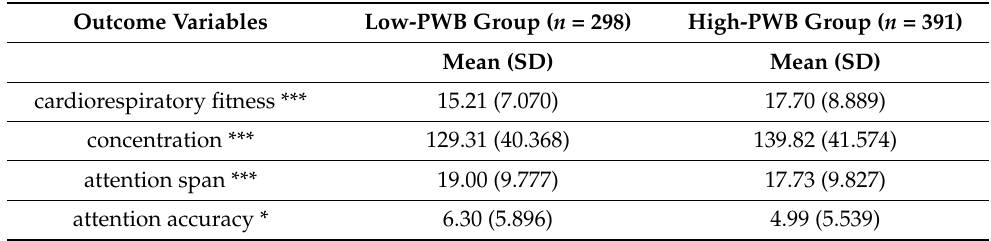
Table 4. Mean scores of cardiorespiratory fitness and cognitive function between high and low PWB